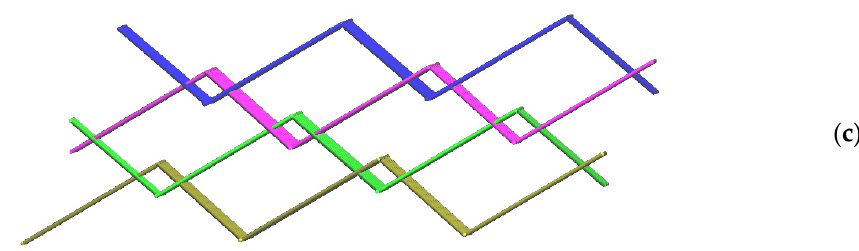
Figure 4. ( a ) Coordination environment of the Ni(II) ion in 3 and 4 . Symmetry transformations used to generate equivalent atoms: (A) x, y + 1, z. ( b ) A drawing showing the sql topology. ( c ) A drawing showing the polycatenation.